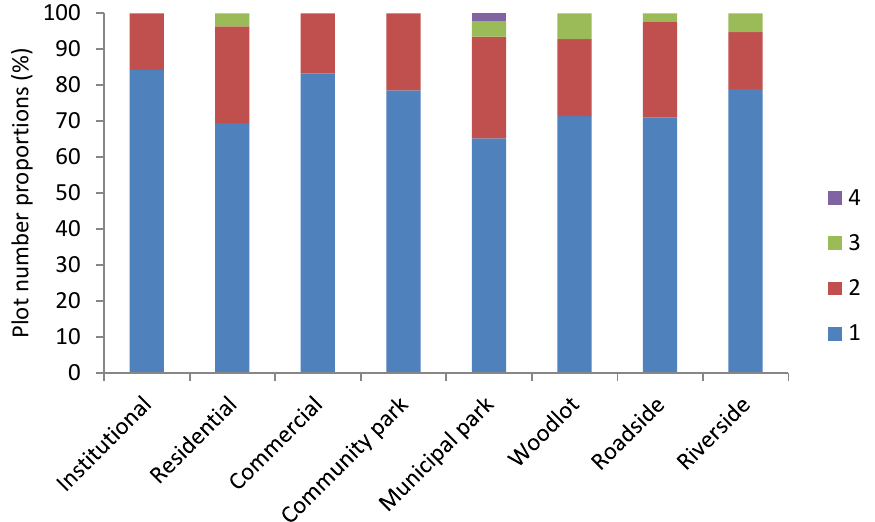
Figure 5. Distribution of invasive ruderal species by number in each plot for different LUTs.